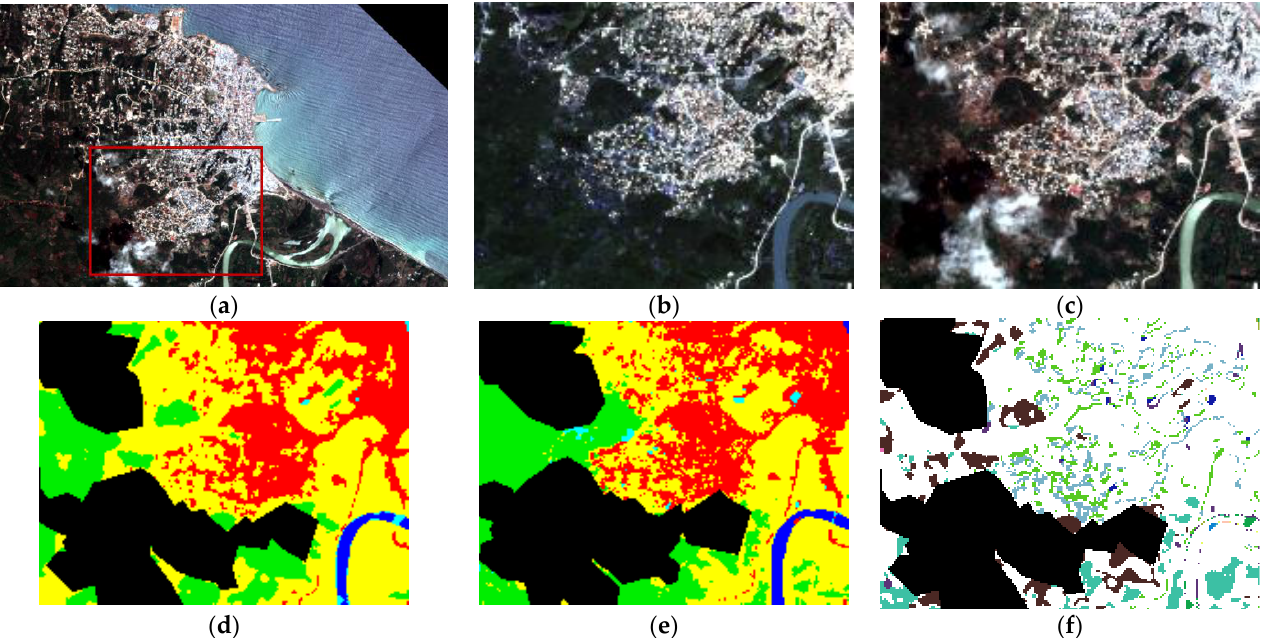
Figure 14. Details of the southwestern “urban/anthropogenic” sector of Jérémie: ( a ) RGB composition of the optical image acquired in 2018 with the indication of the considered crop; ( b ) RGB composition of the optical crop acquired in 2017; ( c ) RGB composition of the optical crop acquired in 2018 (image © CNES 2017–2018, distribution Airbus DS); ( d ) classification map corresponding to the crop of 2017; ( e ) classification map corresponding to the crop of 2018; ( f ) change map corresponding to the timeframe 2017–2018. The legend of the change map is given in Figure 9, while the legend of the classification maps is provided in Table 1.